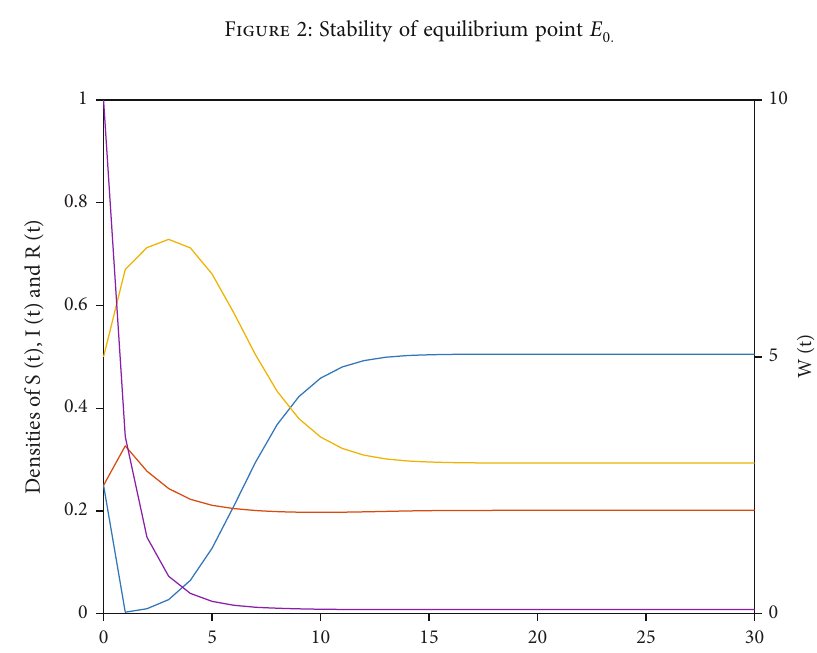
Figure 2: Stability of equilibrium point E